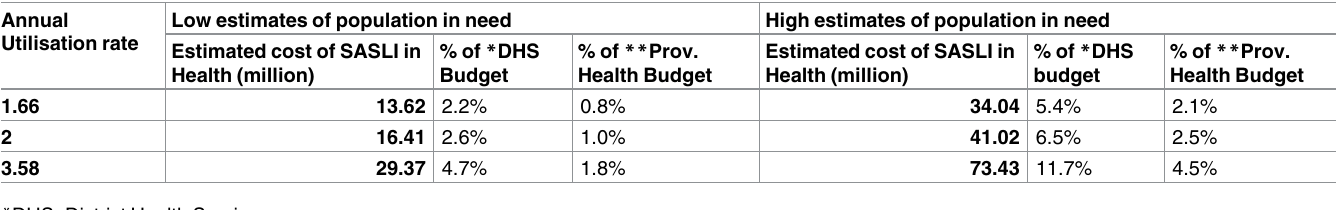
Table 4. Cost of SASLI servicesas a proportion of the District and Provincial health budgets (in 2013US $). Annual Low estimates of population in need Utilisation rate